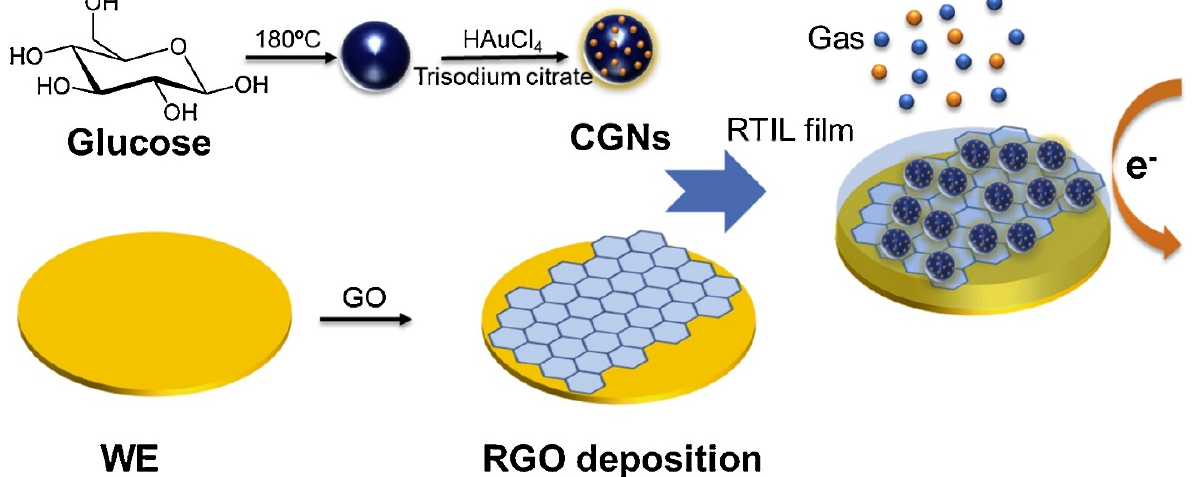
Figure 4. The modified rGO–CGN electrochemical gas sensor preparation procedures for oxygen sensing. Reproduced with permission from [171]. Copyright © 2021 Elsevier B.V. All rights reserved.